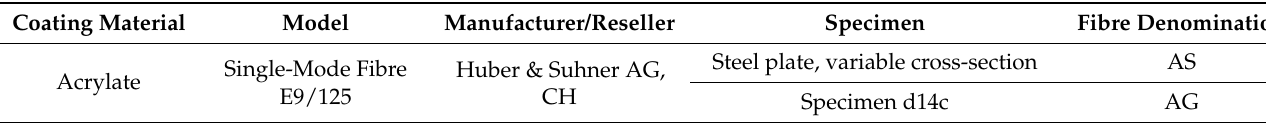
Table 1. Overview of the used fibre optical sensors in the presented experimental